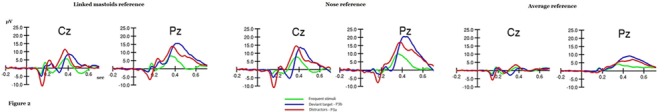
Original P3a, P3b, and frequent stimuli waves at Cz and Pz sites, for linked mastoids, nose, and average references.